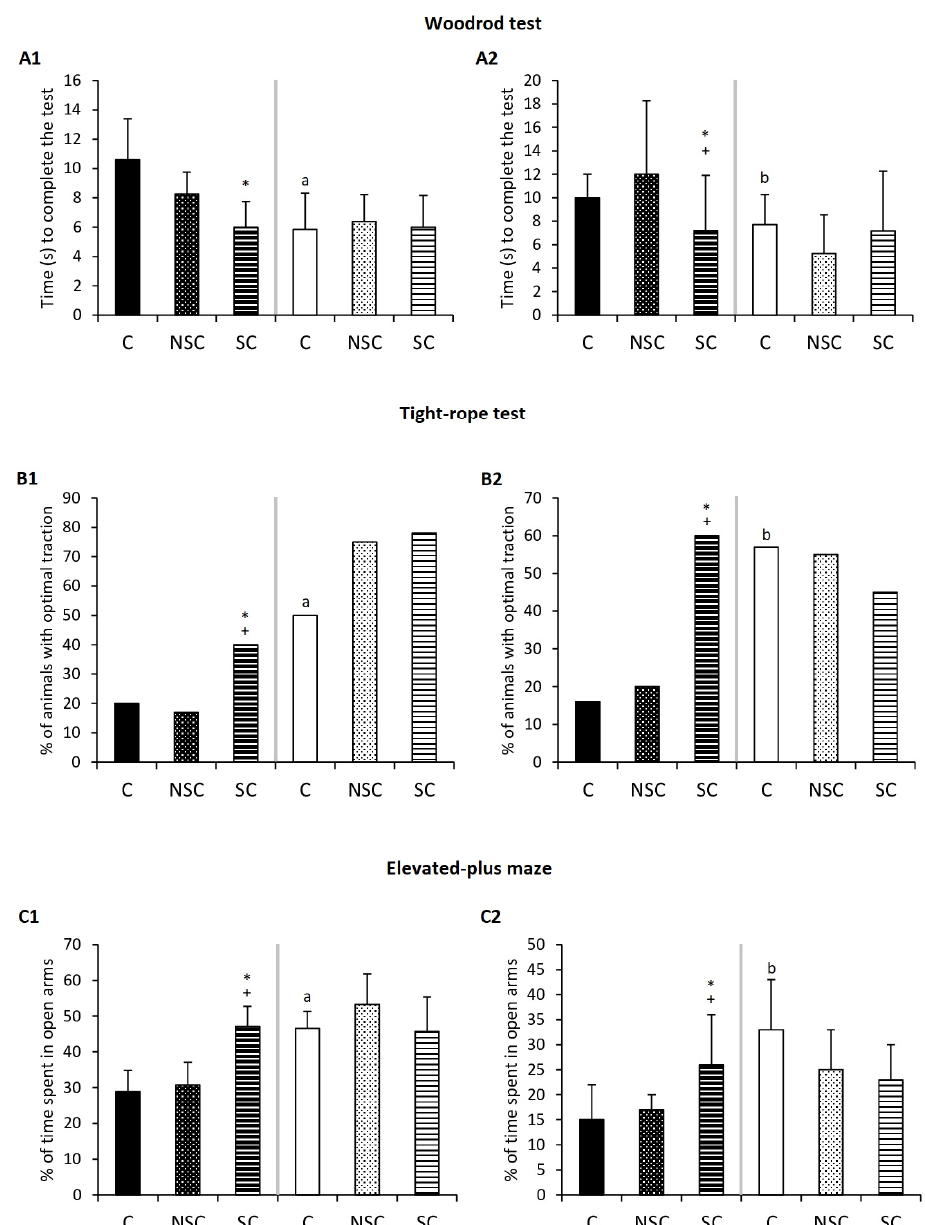
Figure 1. Behavioral parameters. ( A ) Time to complete the wood-rod test in seconds. ( B ) Percentage (%) of animals with optimal traction in the tight-rope test. ( C ) Percentage (%) of time spent in open arms in the elevated plus maze. The results corresponding to chronologically adult and old mice are shown in A1, B1, and C1, and to adult prematurely-aging mice (PAM) and non-prematurely-aging mice (NPAM) are shown in A2, B2, and C2. Each column shows the mean ± standard deviation of 6–15 values corresponding to the same number of animals. After a statistical analysis comparing the means with the Mann–Whitney U test for independent samples, significant differences were observed in the indicated experimental groups. *: p < 0.05 with respect to the values obtained in their corresponding control group. +: p < 0.05 with respect to the values obtained in the corresponding NSC group. a: p < 0.05 with respect to the values obtained in old mice C. b: p < 0.05 with respect to the values obtained in PAM C. C: control group (old mice/PAM: n = 6; adult mice/E-NPAM: n = 7). NSC: non-skin-to-skin contact (old mice/PAM: n = 6; adult mice/E-NPAM: n = 15). SC: skin-to-skin contact (old mice/PAM: n = 6; adult mice/E-NPAM: n =